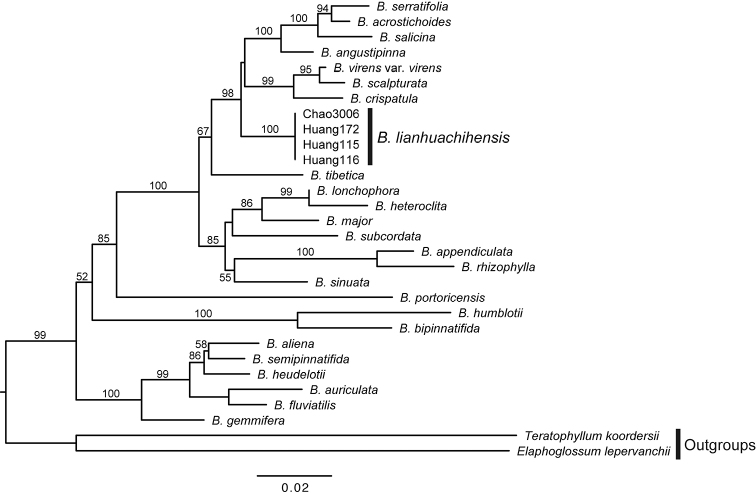
Chloroplast DNA phylogeny of 25 Bolbitis species and two outgroups. ML bootstrap support values are indicated on each branch.